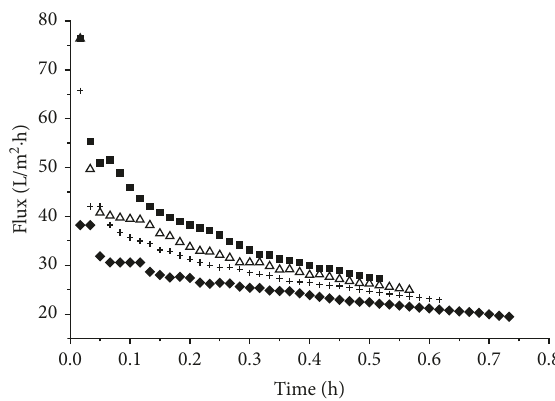
Figure 1: The flux permeate during the ultrafiltration process at pH 7.0: trial 1 (